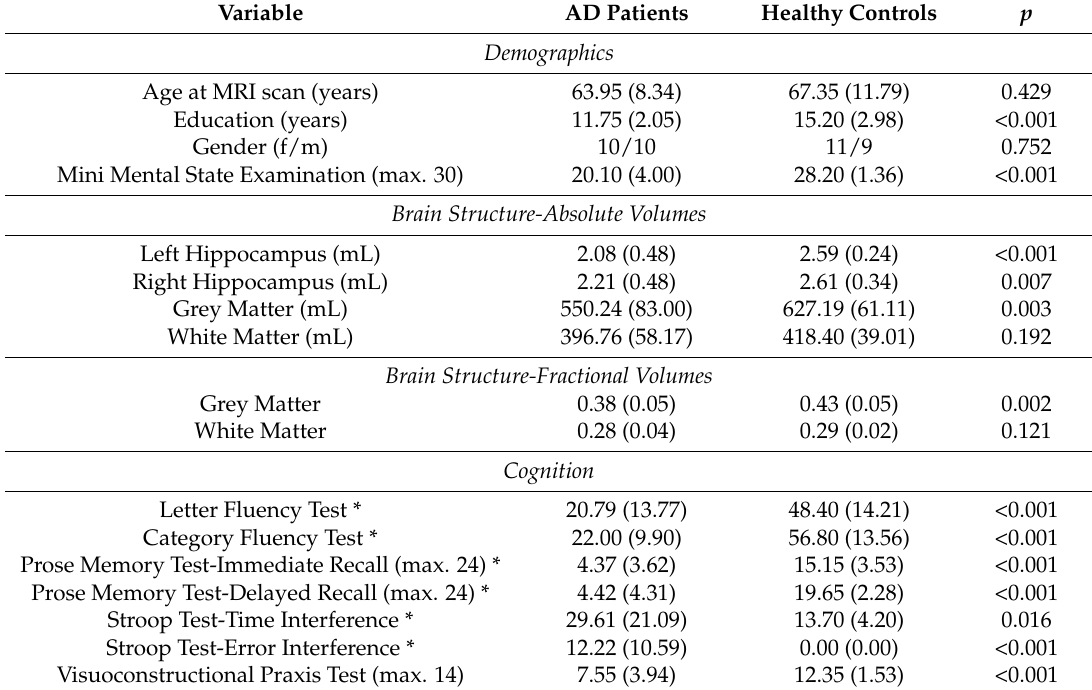
Table 1. Demographic data, Structural MRI & Neuropsychology